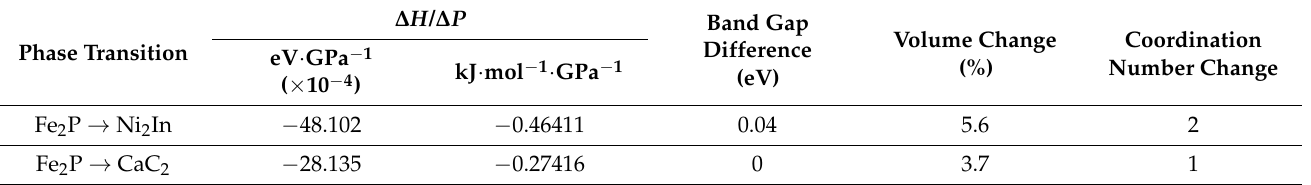
Table 3. Enthalpy difference, band gap difference, volume change, and coordination number change across the Fe 2 P → Ni 2 In and Fe 2 P → CaC 2 phase transitions for TiO 2 . ∆ H / ∆